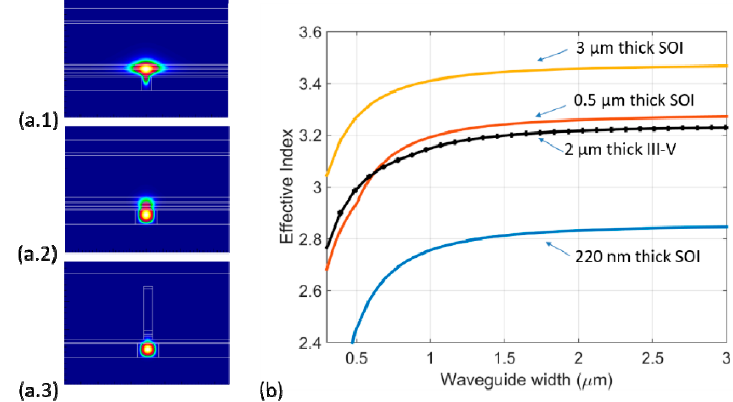
Figure 1. ( a ) Optical mode profiles of the heterogeneous (Si/III-V) waveguide with 500 nm thick silicon in 3 different operating regimes: ( a.1 ) n m − v > n si with a slab III-V on 0.7 µ m wide silicon waveguide, which results in higher confinement in the active III-V layer. ( a.2 ) n m − v ≈ n si with a slab III-V on 1.3 µ m wide silicon waveguide, which results in equal confinement in the III-V and silicon. ( a.3 ) n m − v < n si with 0.5 µ m wide III-V on 1.3 µ m wide silicon waveguide, which results in higher confinement in silicon. ( b ) Effective indices of strip silicon waveguides of three thicknesses (220 nm, 500 nm and 3 µ m) with varying width is plotted together with the effective index of a typical 2 µ m thick III-V waveguide (used in [29]). Noted that all simulations were carried out at 1550 nm wavelength.